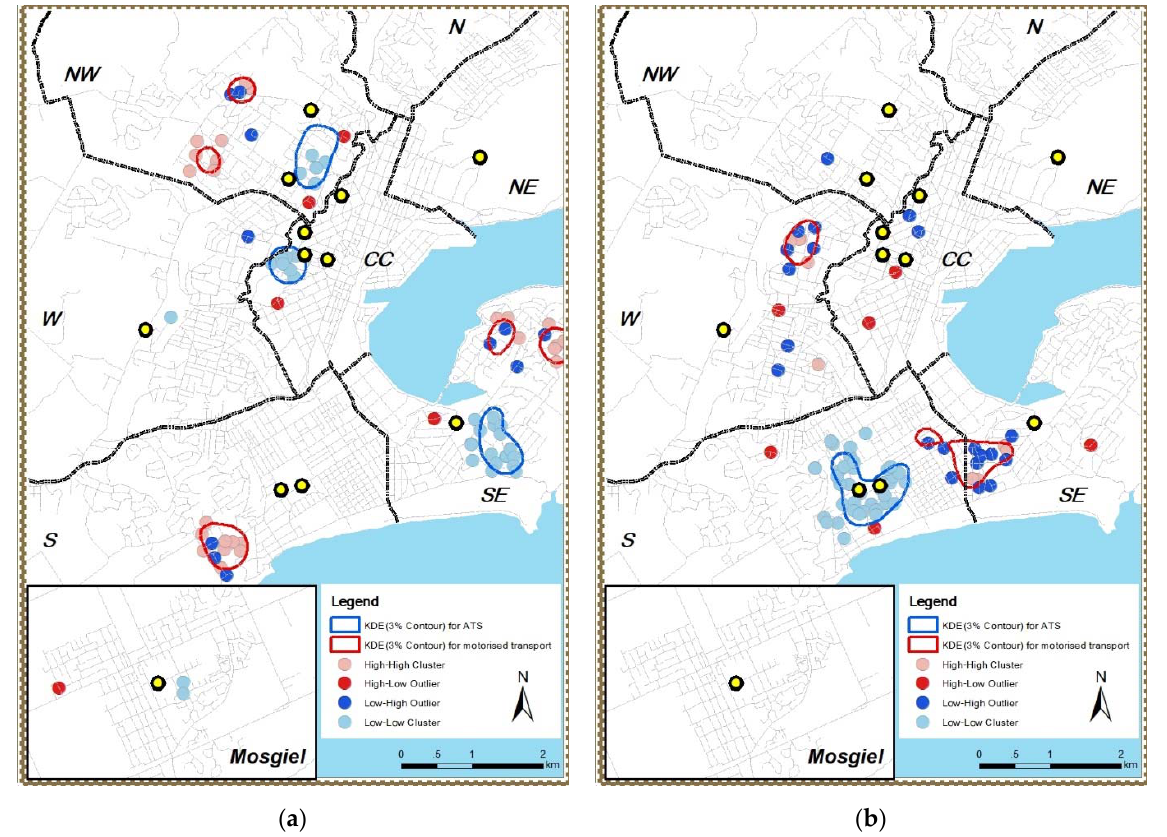
Figure 6. KDE and LISA transport modes distribution on residential density: ( a ) medium home neighbourhood residential section density; ( b ) high home neighbourhood residential density.